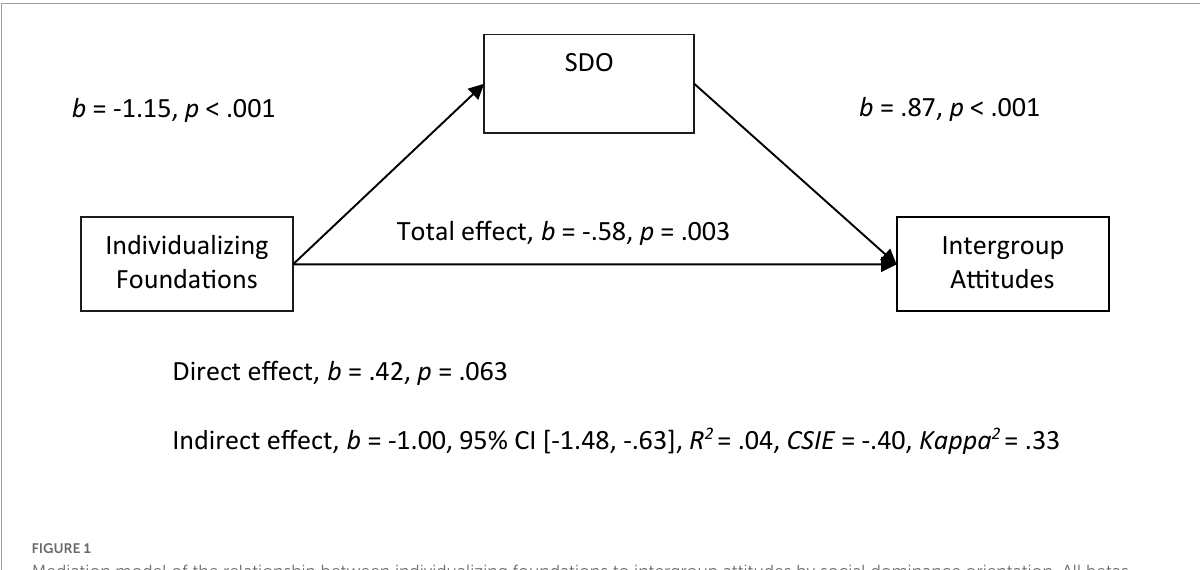
FIGURE1 Mediation model of the relationship between individualizing foundations to intergroup attitudes by social dominance orientation. All betas represent unstandardized values from the Bootstrap analysis with 5,000 samples. CSIE represents the completely standardized indirect